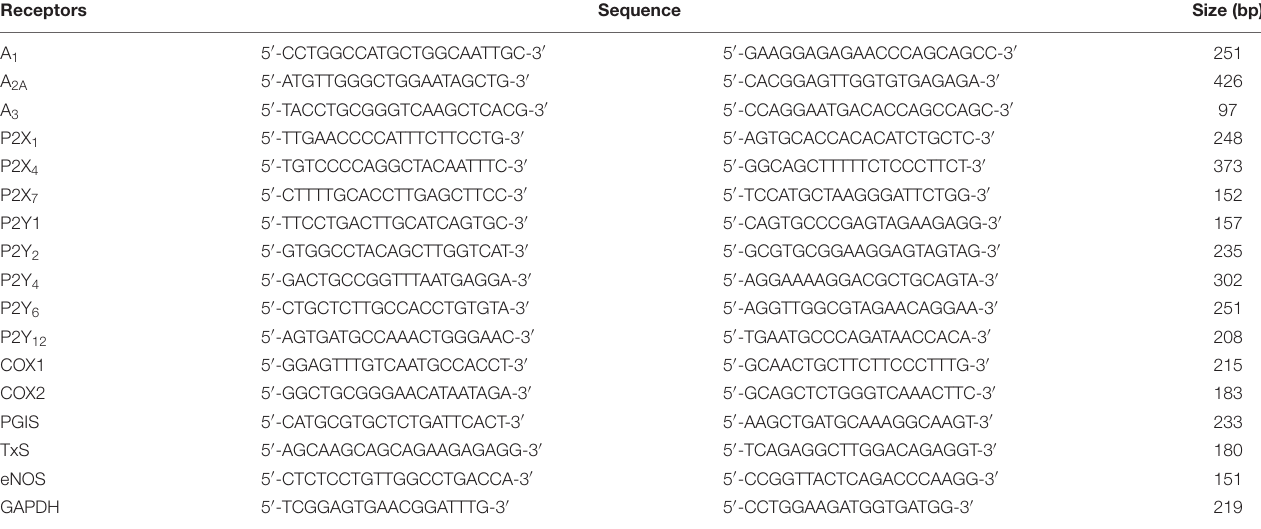
TABLE 1 | Primer information. Receptors Sequence